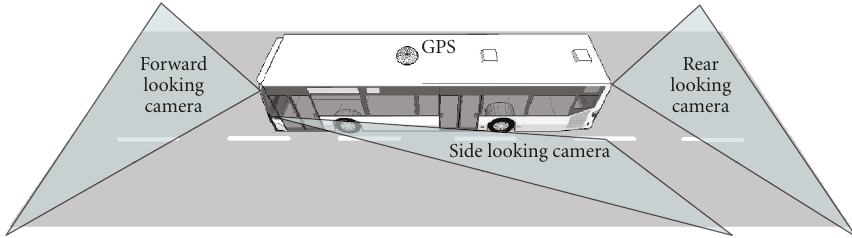
Figure 2: Main vehicle sensors: three cameras (forward, rear, and side looking cameras) and a global positioning system.